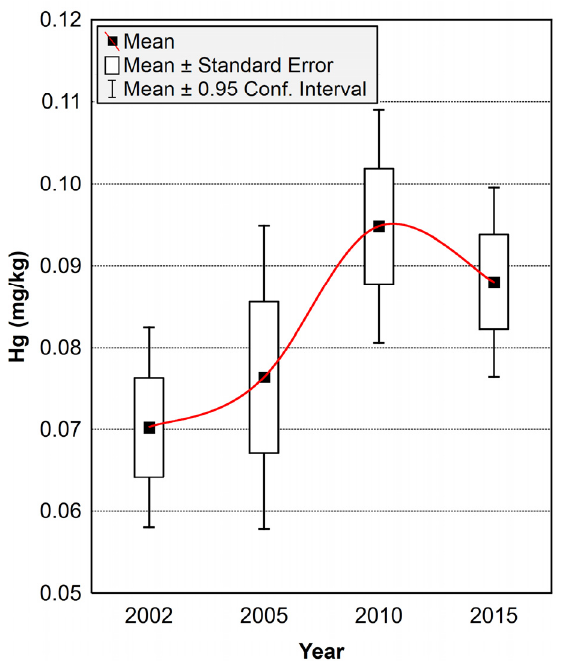
Figure 3. Box plots of Hg according to the year of sampling.